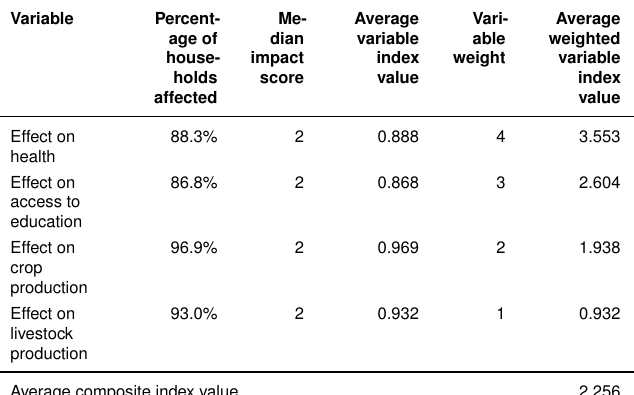
Table 2. Calculation of perception based climate variability